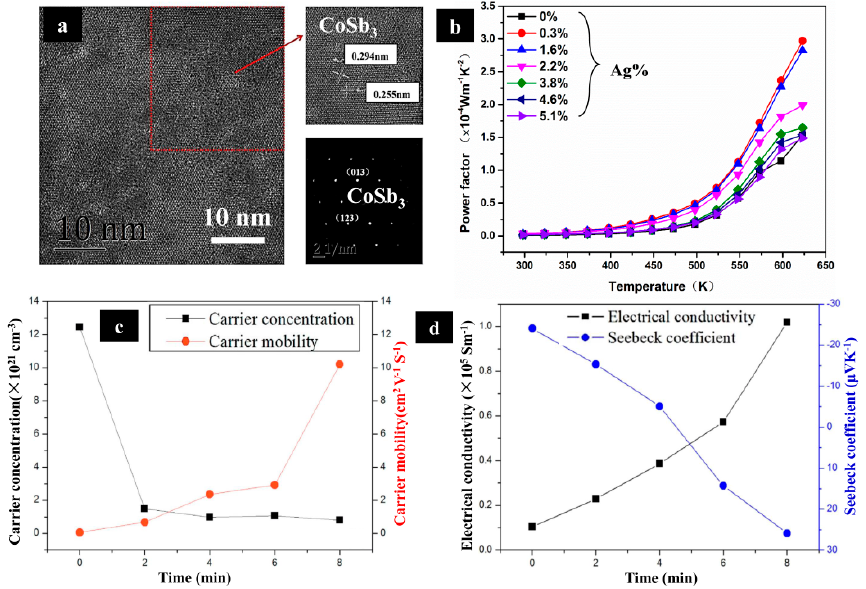
Figure 9. ( a ) HRTEM image of the Ag-doped sample; ( b ) temperature dependence of power factor for Ag − doped CoSb 3 thin film samples [64]; ( c ) carrier concentration and Hall mobility of CoSb 3 films with Sb excess with deposition time; ( d ) Seebeck coefficient and electrical conductivity of CoSb 3 films with Sb excess with deposition time [65].